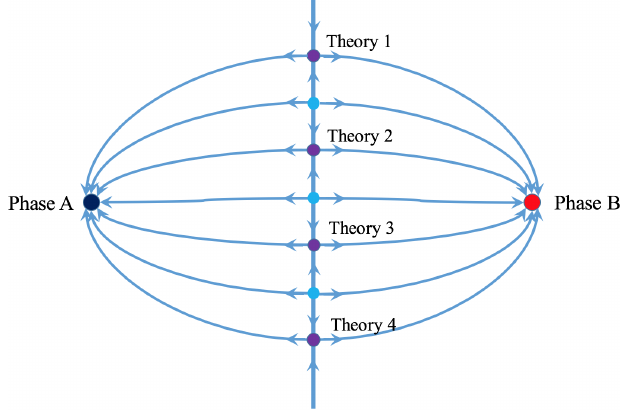
FIG. 4. A schematic renormalization flow diagram for degen- erate quantum critical